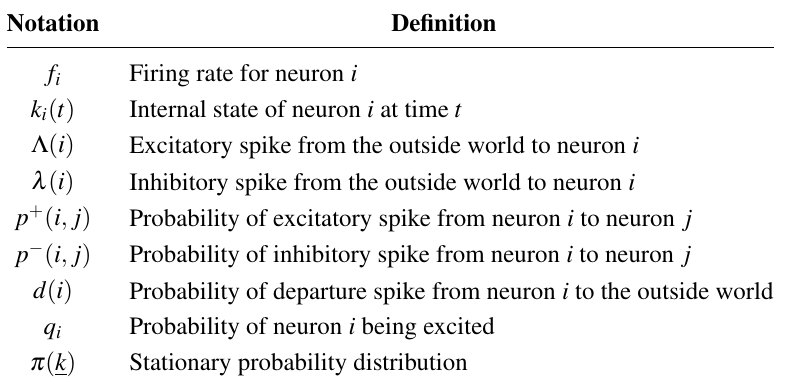
Table 1. List of the random neural network (RNN) training model symbols